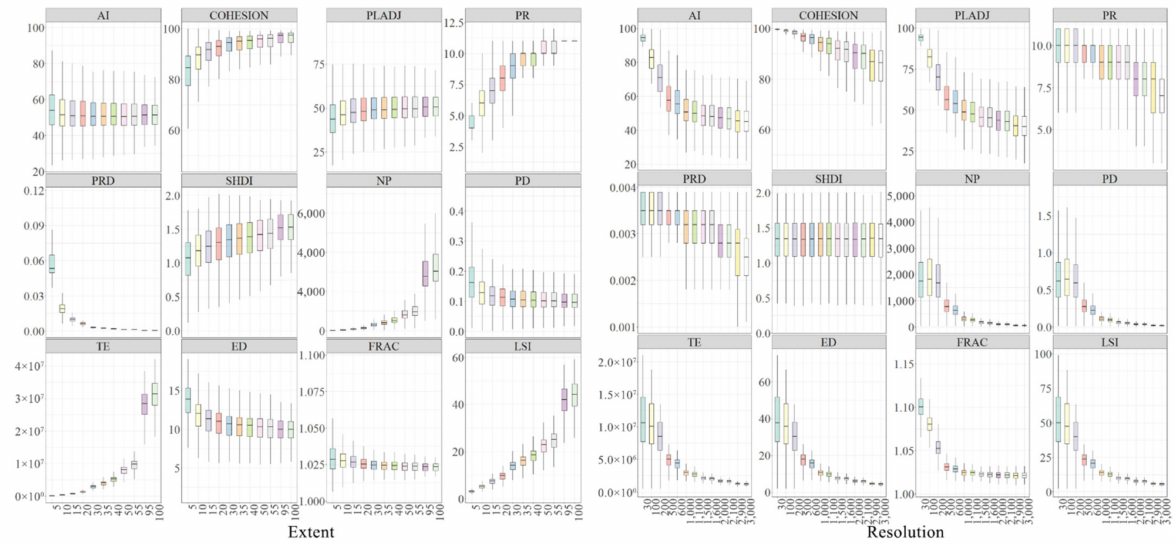
Figure 9. The statistical distribution diagrams of test